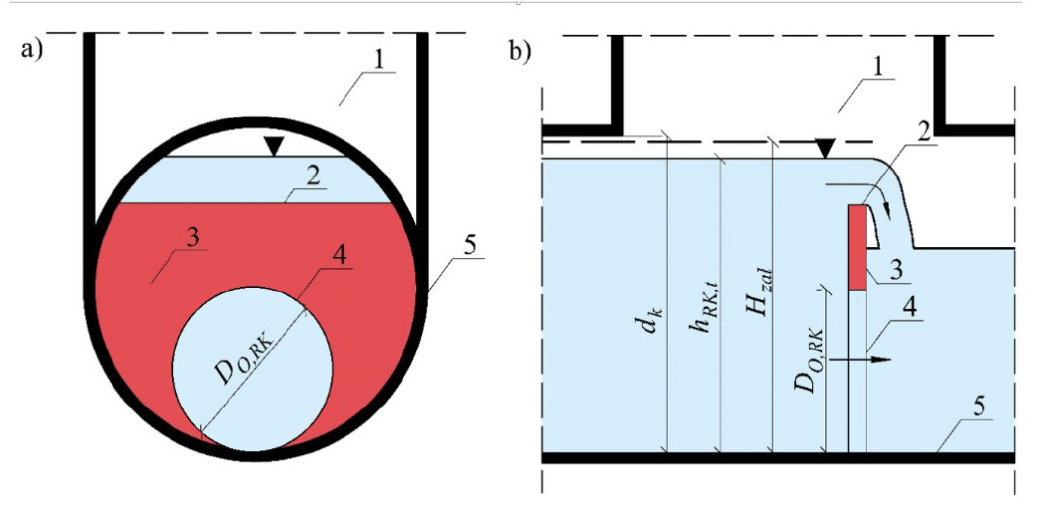
Figure 4: Scheme of the damming partition installed in a sewage manhole (a) cross section; (b) longitudinal section; 1 - sewer manhole, 2 - overflow edge, 3 - piling partition, 4 - flow opening, 5 – canal, D height in the canal during the time t , H